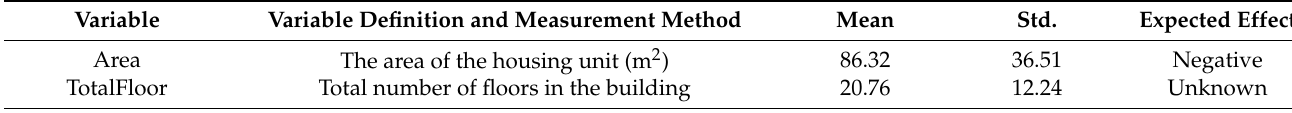
Table 2. The structural variables of the rental housing in this